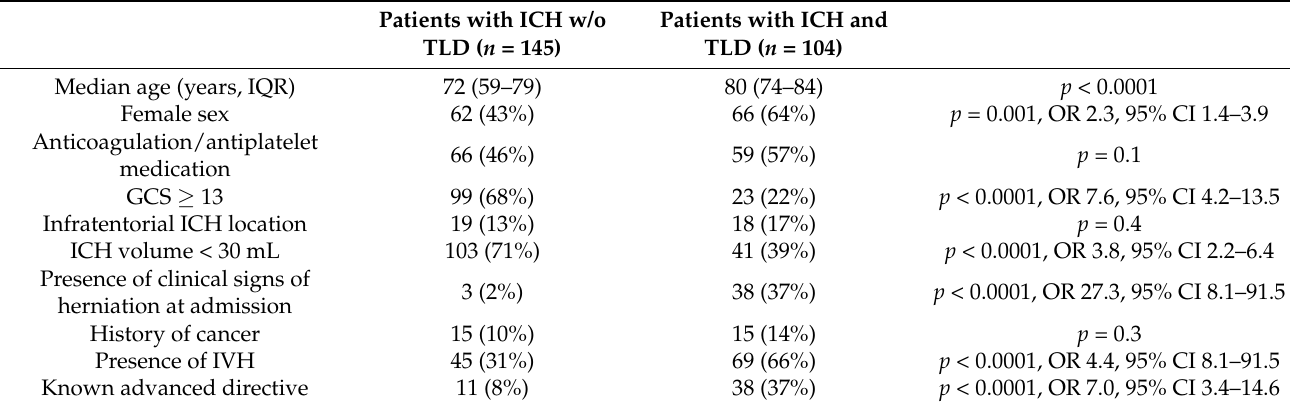
Table 1. Patients’